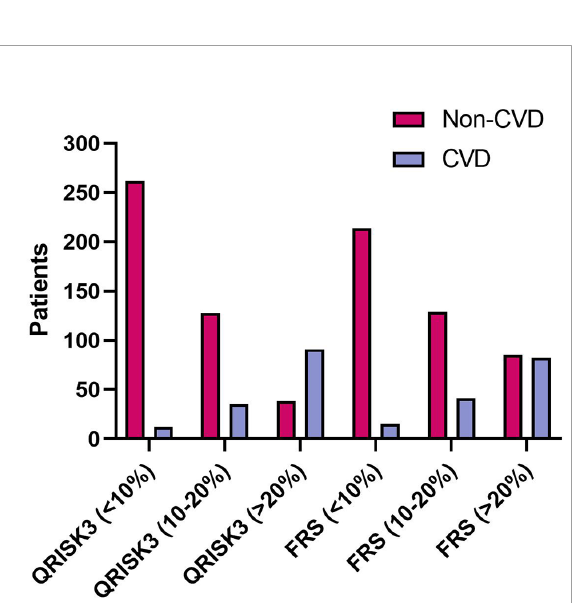
FIGURE 4 The number of patients considered low (<10%), median (10% – 20%) and high (>20%) risk between patients according to QRISK3 and FRS. Legend: QRISK3 identi fi ed the majority of non-CVD patients as low or intermediate risk, with 262 (61.2%) patients classi fi ed as low risk and 128 (29.9%) patients classi fi ed as intermediate risk. Furthermore, QRISK3 identi fi ed 91 (65.9%) of CVD patients as high-risk. However, FRS classi fi ed some non- CVD patients as high risk. The number of CVD patients classi fi ed as high risk was 82 (59.4%), while the number of non-CVD classi fi ed as high risk was 85 (61.6%). CVD, cardiovascular disease; QRISK3, QRESEARCH Risk estimator version 3; FRS, Framingham risk